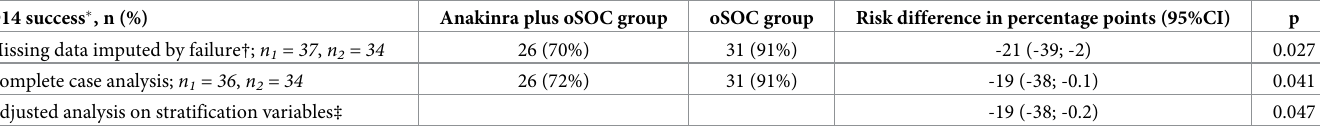
Table 2. Number (percentage) of participants alive and without need of mechanical ventilation or ECMO at day 14.